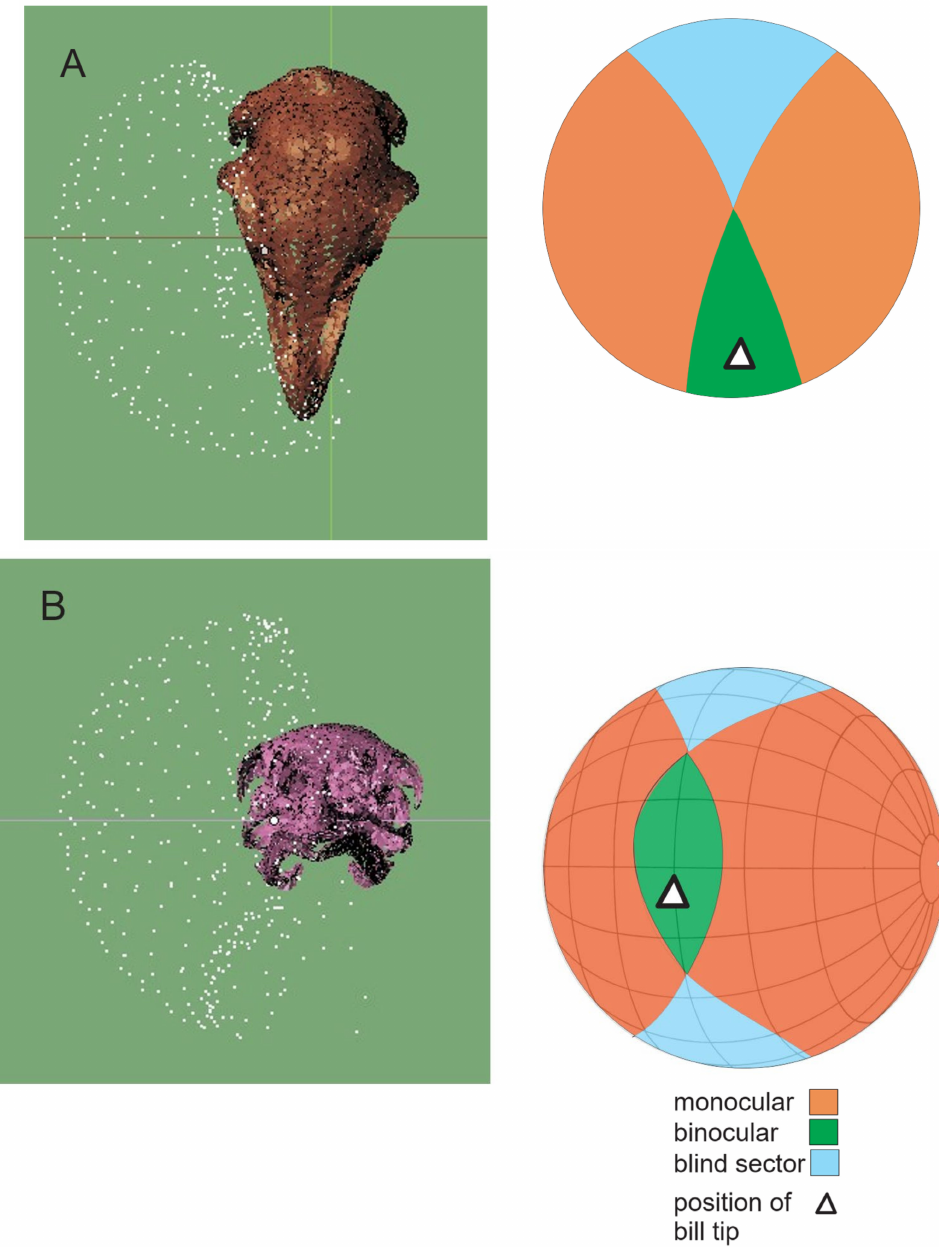
Figure 8. Megalapteryx didinus , visual field plot, as reconstructed and graphically after the convention of Martin [1], in ( A ) dorsal and ( B ) frontal